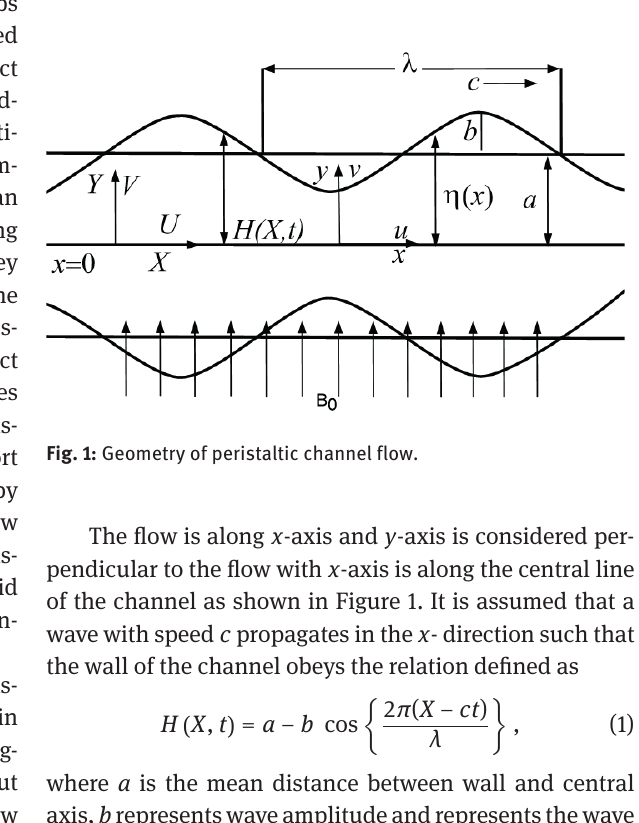
The flow is along x -axis and y -axis is considered per- pendicular to the flow with x -axis is along the central line of the channel as shown in Figure 1. It is assumed that a wave with speed c propagates in the x - direction such